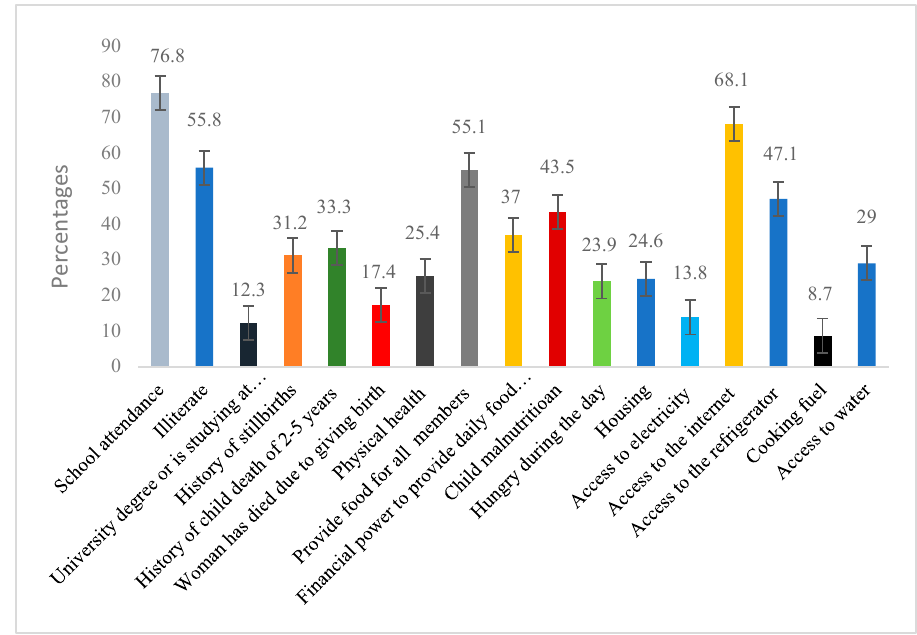
Figure 6. The intensity of poverty (A) in urban households (in percent).